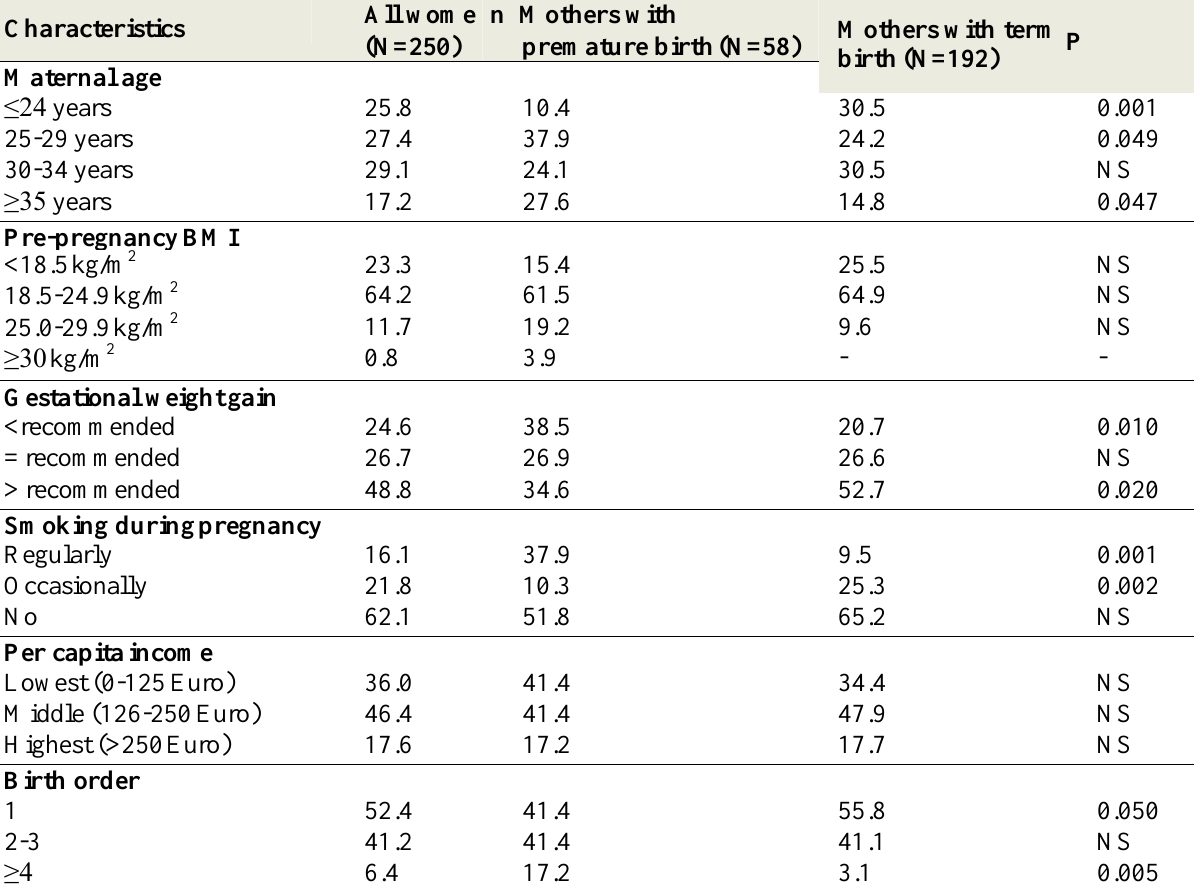
Table 1. Distribution of maternalcharacteristics